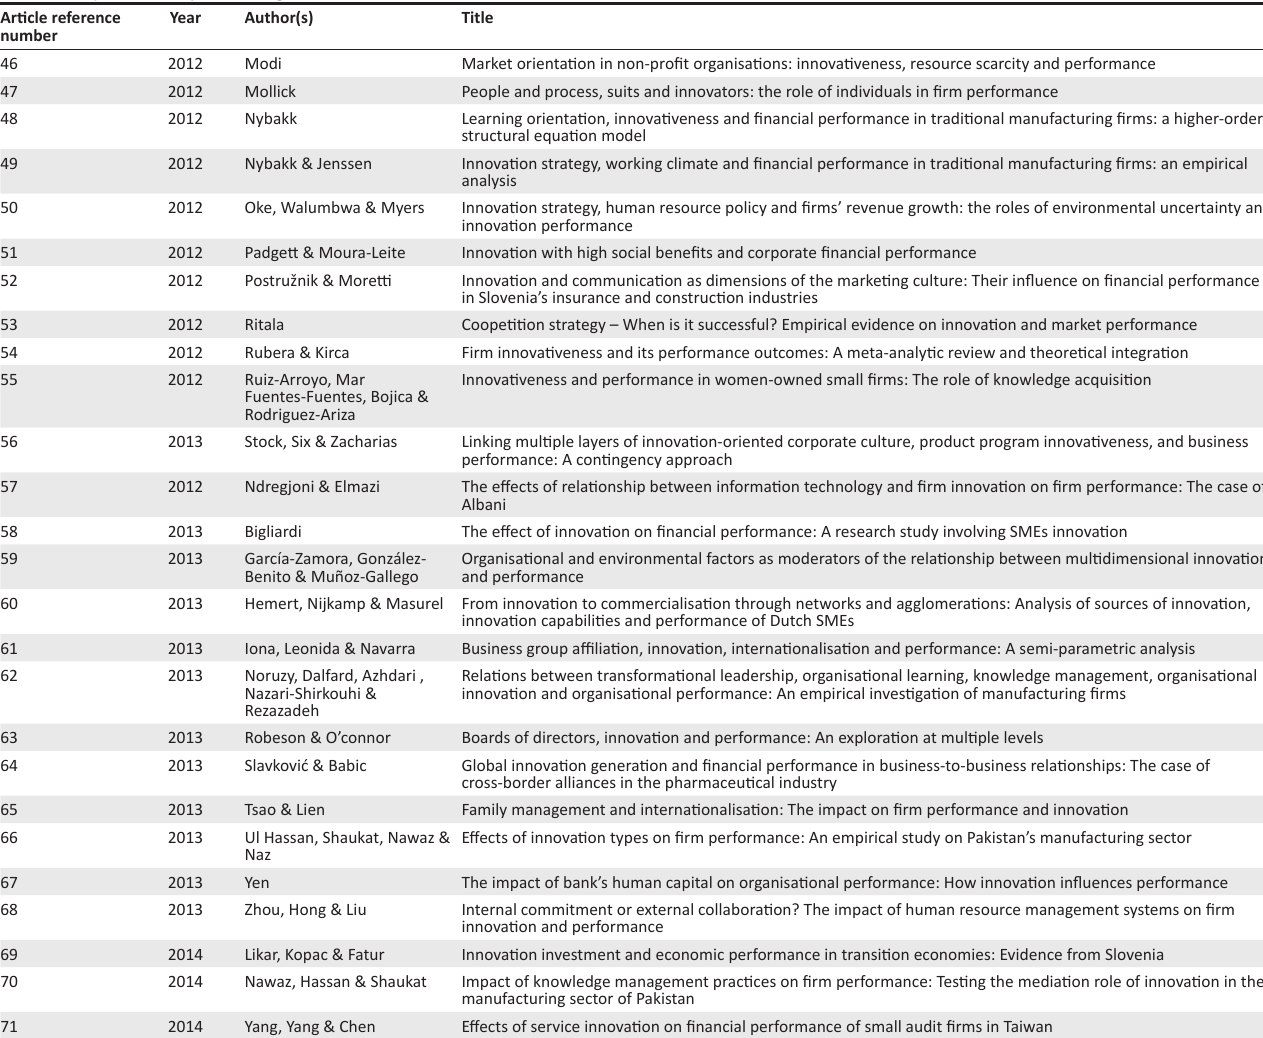
TABLE 1-A1 (Continues...): Chronological list of articles selected for the